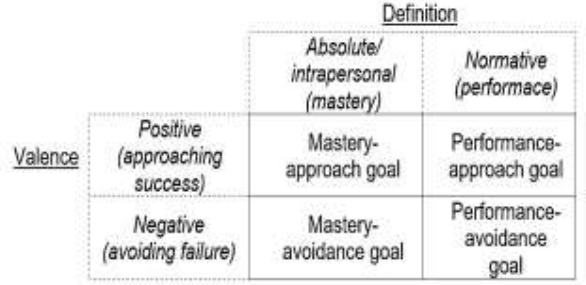
Figure 2. The 2 x 2 Achievement Goal